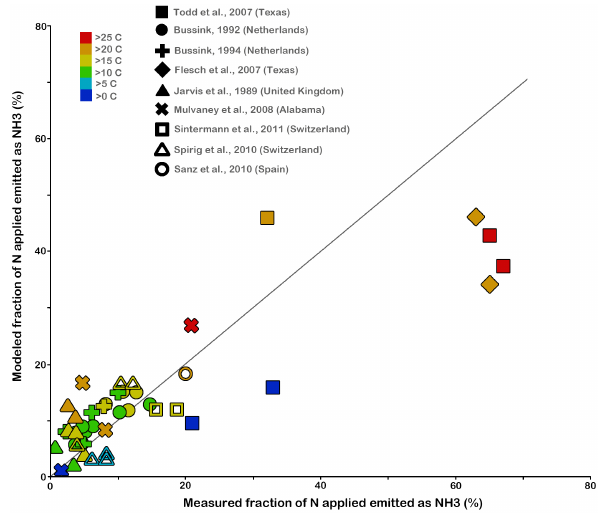
Figure 3. Comparison of model to measurements for percentage of nitrogen lost as NH 3 emissions from synthetic fertilizer (see Ta- ble S2) for a range of studies. Symbol color gives the latitude at which the emissions occurred; symbol shape gives the study and type of synthetic fertilizer